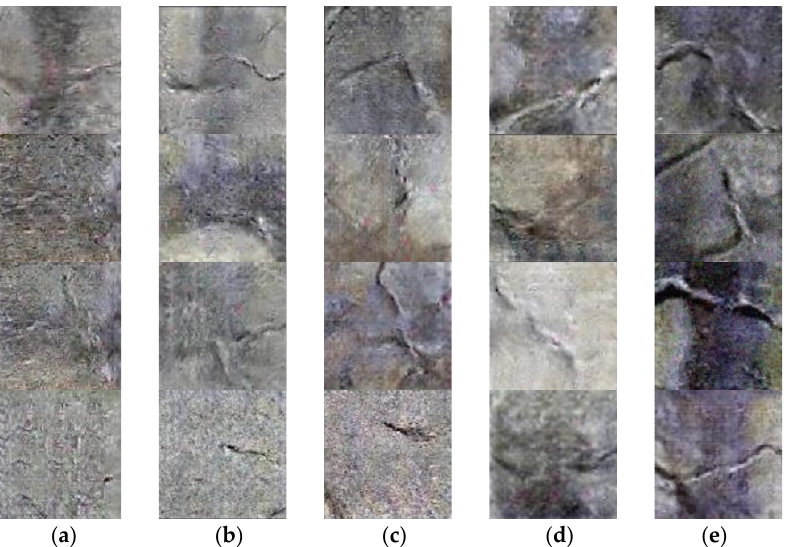
Figure 12. Crack images generated by different models. ( a ) Crack images generated by GAN. ( b ) Crack images generated by WGAN. ( c ) Crack images generated by WGAN-GP. ( d ) Crack images generated by DCGAN. ( e ) Crack images generated by CEGAN.